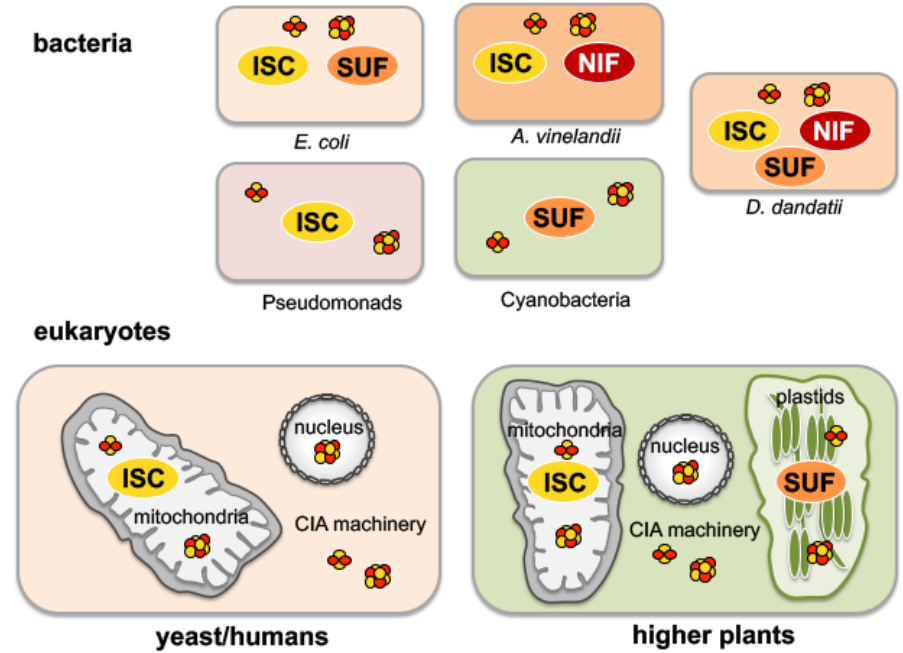
Figure 2. Possible links of Fe-S cluster assembly systems in prokaryotes and eukaryotes. Bacterial organisms harbor different complements of the NIF (nitrogen fixation), ISC (iron-sulfur cluster), and SUF (sulfur mobilization) systems. The NIF system is specialized for the assembly of nitrogenase in azototrophic bacteria. In bacteria like E. coli , both the ISC and SUF systems are present, while Pseudomonads contain only the ISC system and Cyanobacteria contain only the SUF system, and in Dickeya dandatii all three systems are present. The ISC assembly machinery of mitochondria is likely inherited from an ancestor of α -proteobacteria, the evolutionary origin of these organelles. The SUF machinery of plastids in higher plants has been likely inherited by endosymbiosis of a photosynthetic bacterium. The cytosolic iron-sulfur protein assembly (CIA) machinery for the maturation of cytosolic and nuclear Fe-S proteins depends on the mitochondrial ISC assembly machinery. These three systems are highly conserved in eukaryotes from humans to yeast and plants.